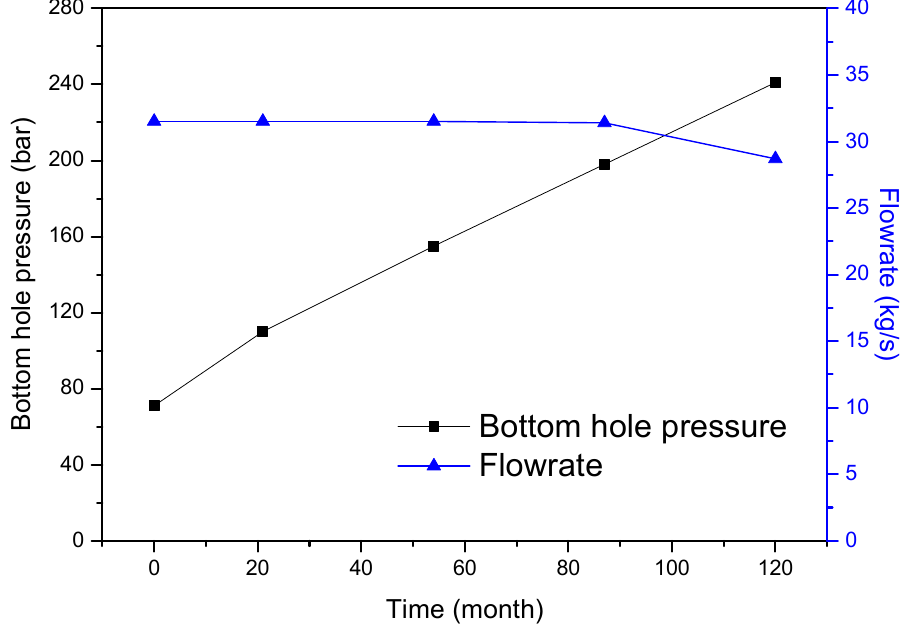
Figure 4. Variations in the reservoir pressure, bottom hole pressure, and flow rate over the injection period.